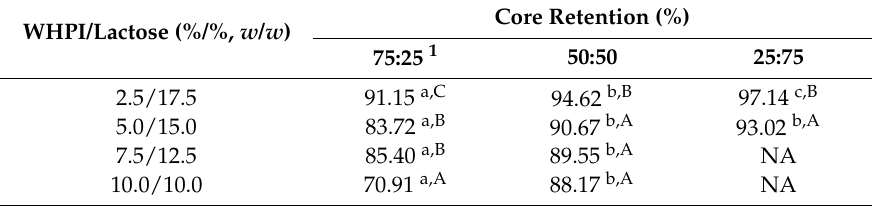
Table 3. The effect of wall composition and wall-to-core ratio on core retention during microencapsulation. Core Retention (%) WHPI/Lactose (%/%, w / w ) 75:25